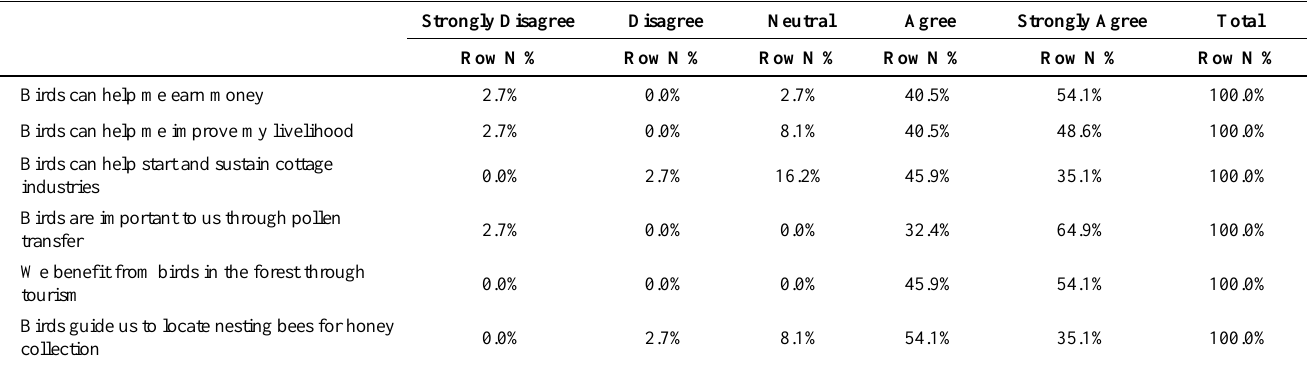
Table 4. Contribution of birds on community